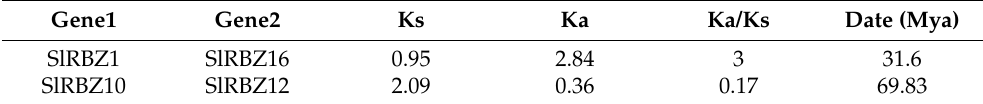
Table 2. Duplicated genes and the dates of the duplication blocks of SlRBZ